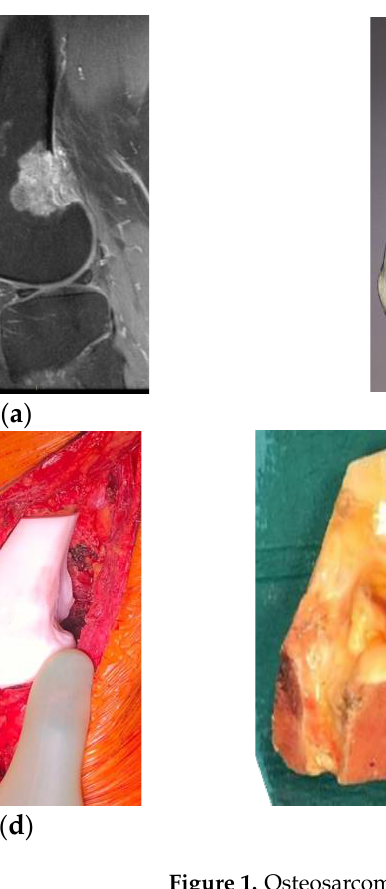
Figure 1. Osteosarcoma in the distal femur of a 56-year-old man. ( a ) High-intensity signal was seen in the sagittal MRI image (T1-fat suppression with contrast) at the posterior to the lateral side of the distal femur. ( b ) Resection planning in the computer-aided design phase. The location of the tumor was highlighted in red via an integrated image of CT and MRI and resection planes were determined with a discussion between surgeons and engineers. ( c ) Surgical planning with a PSG and an artificial bone. To preserve the surface of the knee joint and bone stock, hemi-cortical resection with the PSG, followed by reconstruction with a massive bone allograft was planned. The fitting of the PSG to the bone was confirmed. ( d ) Intraoperatively, after the resection with the PSG, the compatibility of the bone defect with the allograft, which was subsequently resected using the PSG, was confirmed by the artificial bone spacer. ( e ) Resected specimen (left) and resected massive bone allograft (right) via the PSG. We confirmed the identical fitting of a massive bone allograft to the large defect after the tumor resection. ( f ) Postoperative radiograph after the resection of the tumor and reconstruction with massive bone allograft. CT, computed tomography; PSG, patient-specific cutting guide; MRI, magnetic resonance imaging.